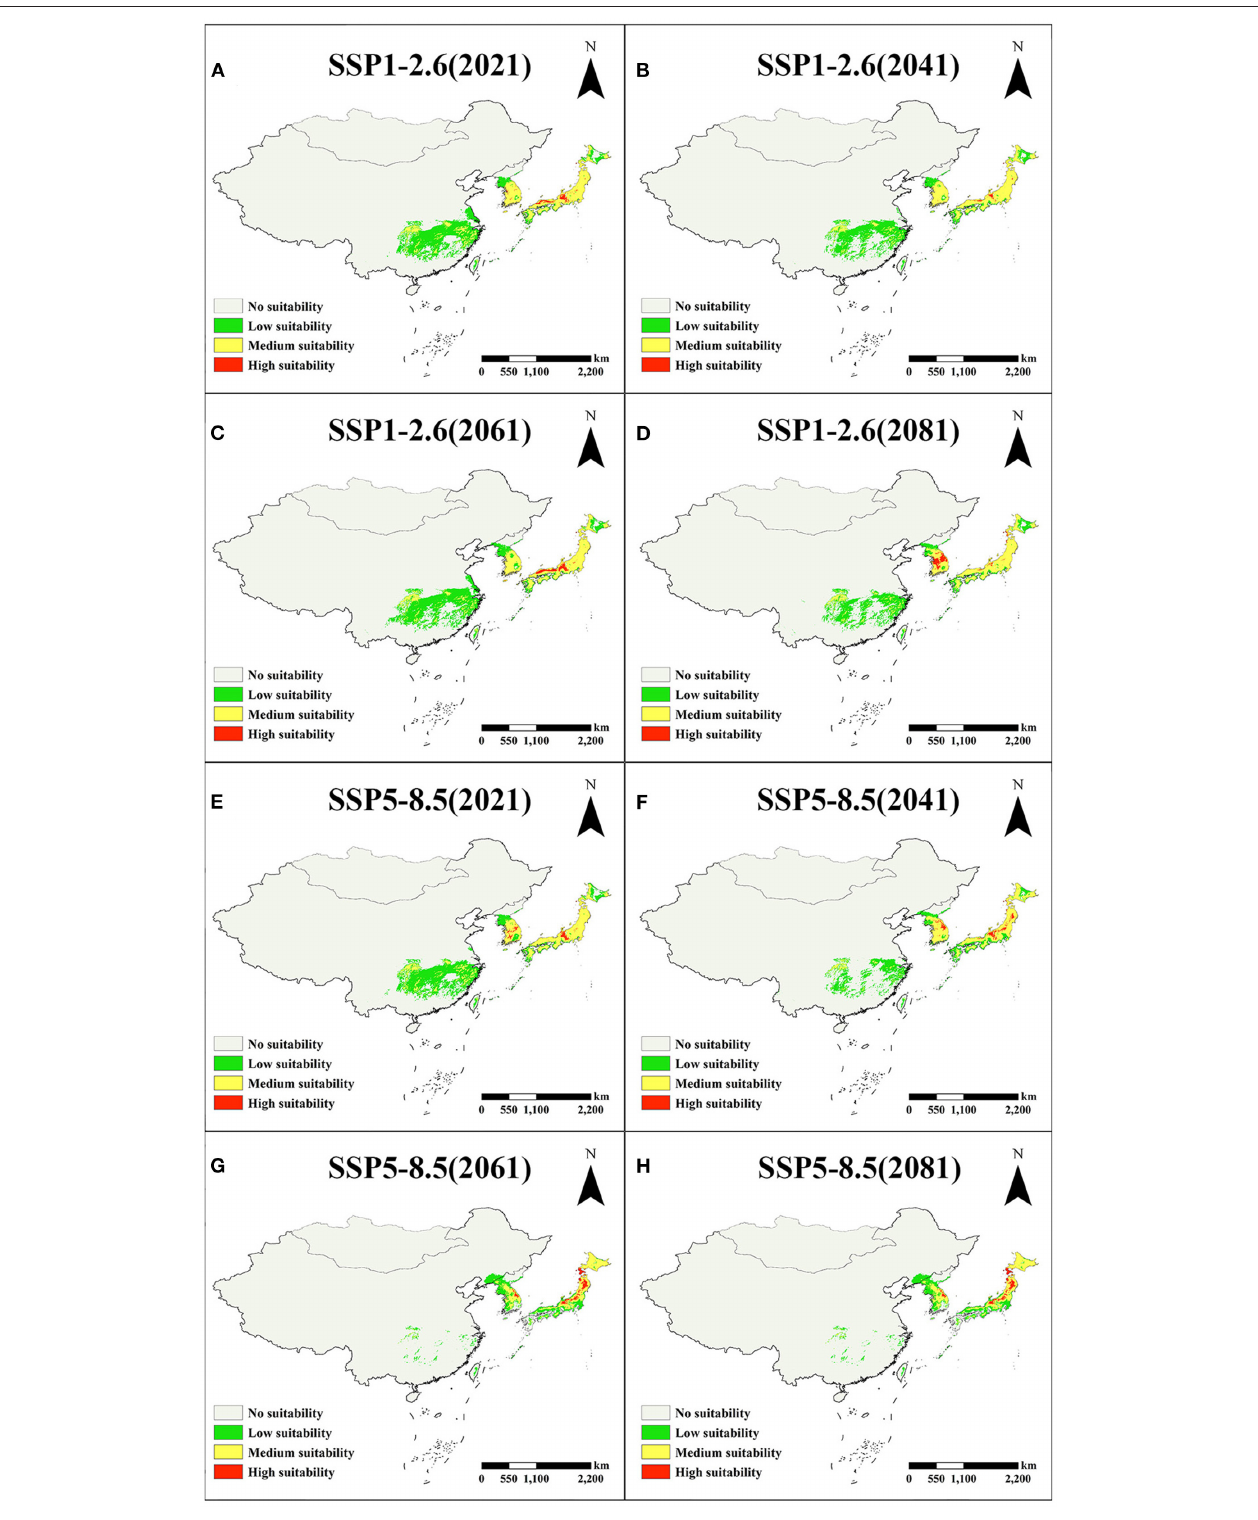
FIGURE 6 | Distribution of A. quinata in East Asia in the SSP1-2.6 and SSP5-8.5 scenarios. (A–D) Distribution under the SSP1-2.6 scenario. (E–H) Distribution under the SSP5-8.5 scenario.